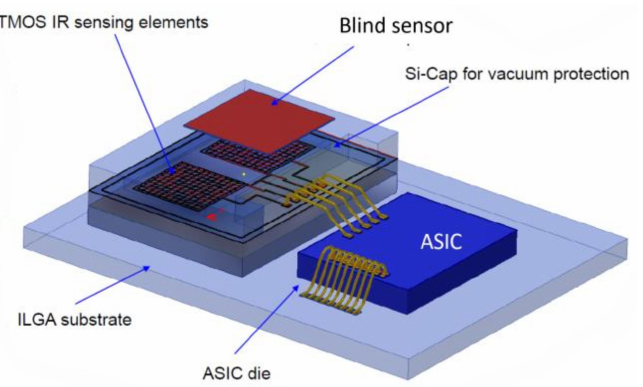
Figure 2. Schematic description of the digital TMOS. ASIC stands for Application Specific Integrated Circuit.